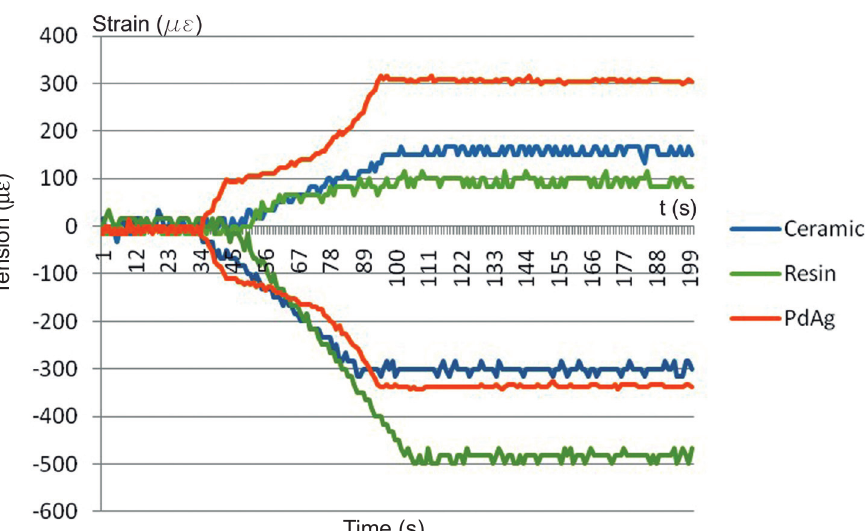
Figure 5- Measurements for tension (positive values) and compression (negative values) forces applied at 20 mm of the distal implant for the different tested materials.